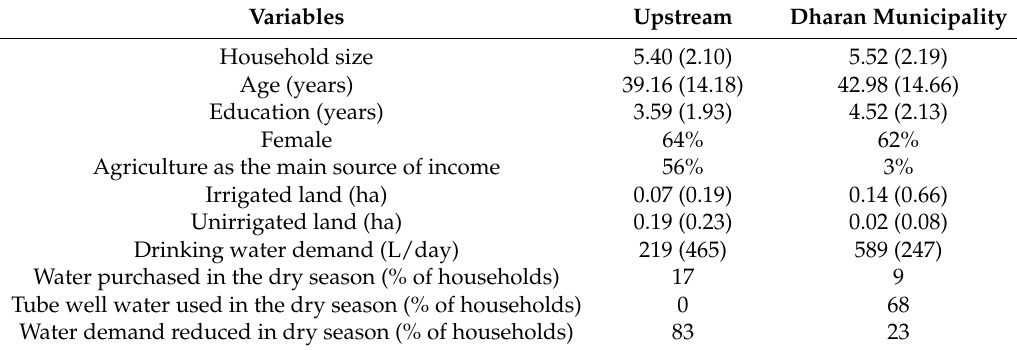
Table 2. Socio-economic characteristics of sample households (standard deviations in